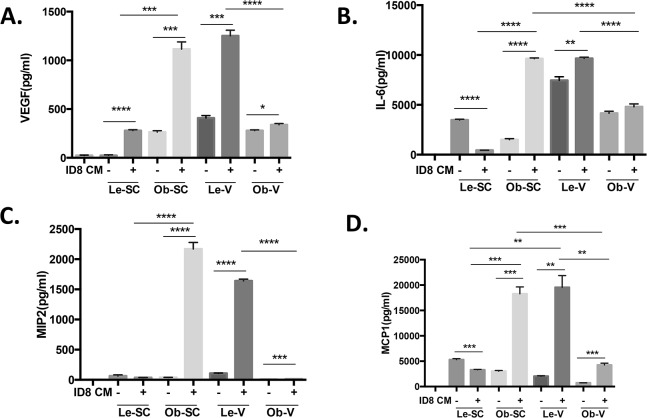
Secretion of VEGF, IL-6, MIP2 and MCP1 by ASC cells in ID8 spheroid-CM.ASC were plated at a density of 20,000/ml in cultured in spheroid medium(control) or medium contained 50% ID8 spheroid-CM for 5 days. Supernatant were collected for Luminex assay. Concentration of VEGF (A) IL-6 (B), MIP2(C) and MCP1 (D).(Shown are mean ± SEM. *, P < 0.05; **, P < 0.01, ***, P<0.001 and ****, P<0.0001. Student t test, two tailed.)